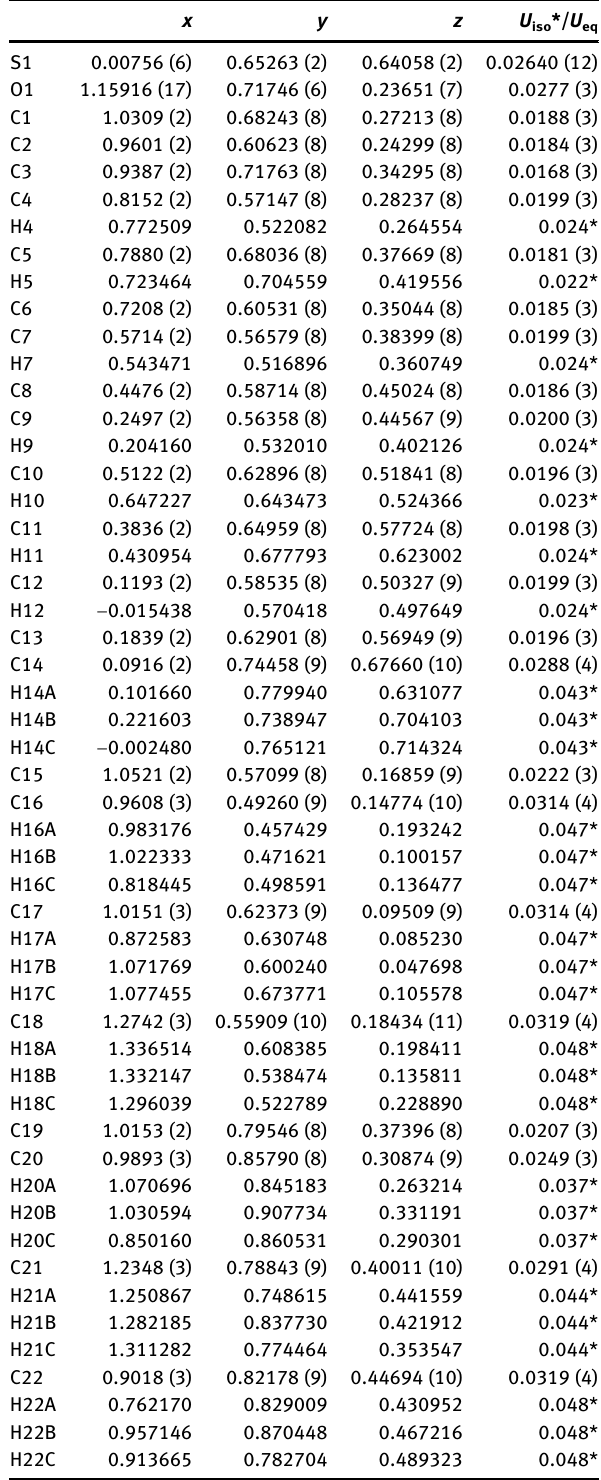
Table  : Fractional atomic coordinates and isotropic or equivalent isotropic displacement parameters (Å 